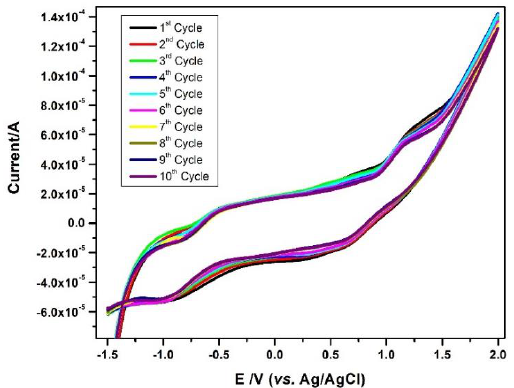
Figure 6. The effect of repetitive cycles on the peak currents of compound 4.